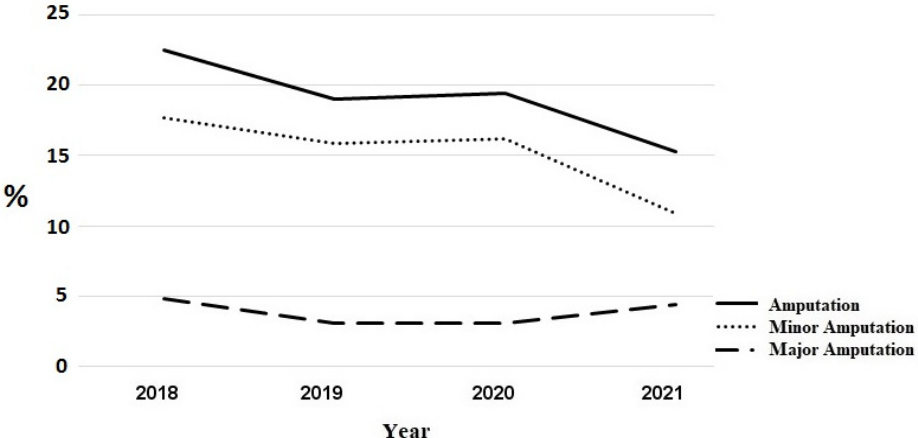
Figure 3. Title: Proportionate course of in-house amputations and transfers for amputation in other hospitals in patients with Rutherford–Becker class 5 (including minor and major). Legend: Proportionate major and minor in-house amputations and transfers for amputation in other hospitals in patients with Rutherford–Becker class 5.